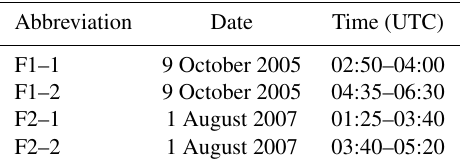
Table 4. Time intervals (plume parts) within F1 and F2 plumes used for the analysis of emission